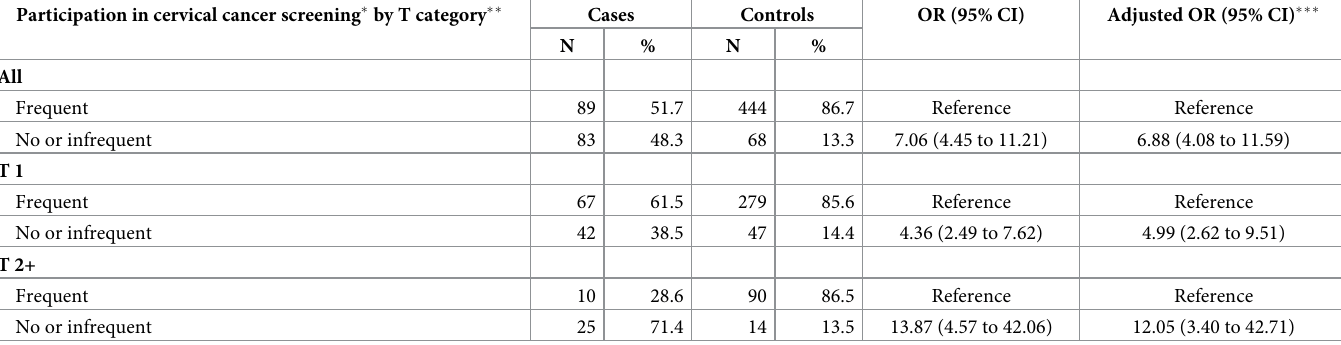
Table 3. Participation in cervical cancer screening during the past ten years among cases and controls, according to T category, squamous cell carcinoma (172 cases and 512 controls). Participation in cervical cancer screening � by T category